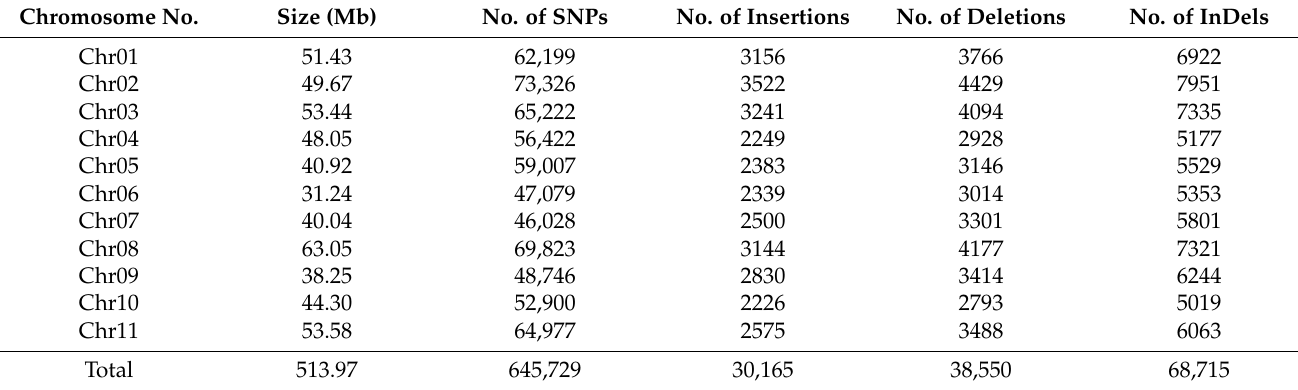
Figure 4. Circos plot to show the density (no. of variants/kb) of SNPs, insertions and deletions in bins of 100 Kb on 11 chromosomes of Phaseolus vulgaris . The outermost track ( A ) denotes the physical distance on each of the eleven chromosomes at 5 Mb break-point. Track ( B ) denotes the chromosome numbers. Track ( C ) shows the area plot of SNP density. Track ( D ) represent the line plot of insertion density and Track E represent the scatter plot of deletion density. Table 3. Distribution of SNPs and InDels on eleven chromosomes of Phaseolus vulgaris